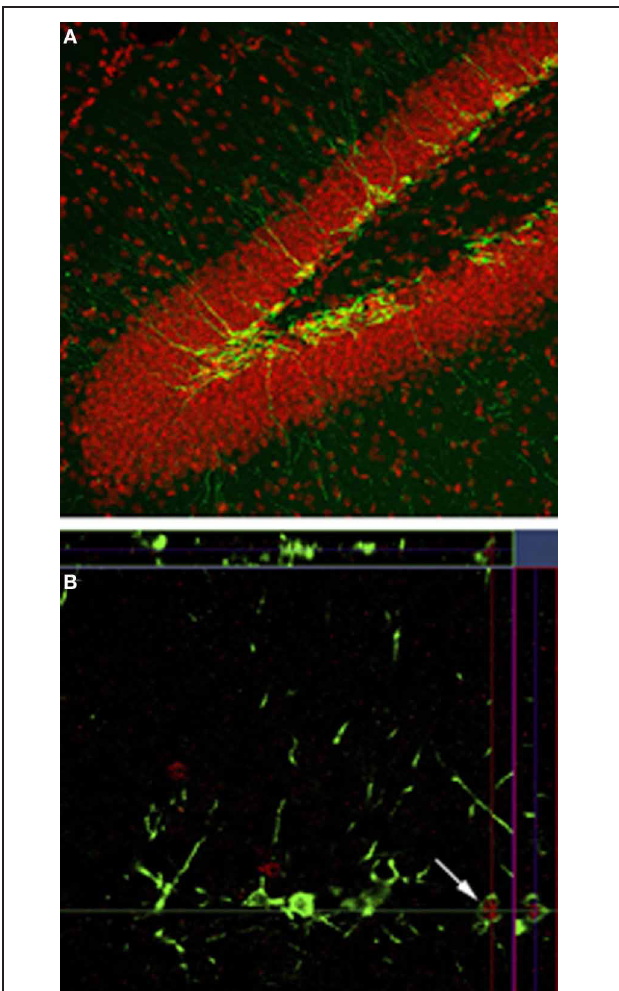
FIGURE 1 | Neurogenesis in the dentate gyrus. (A) Doublecortin labeling (green) shows the presence of immature neurons along the inner edge of the granule cell layer and in the subgranular zone. (B) Doublecortin (green) and zif268 (red) shows the immature neurons that have been activated in response to spatial memory